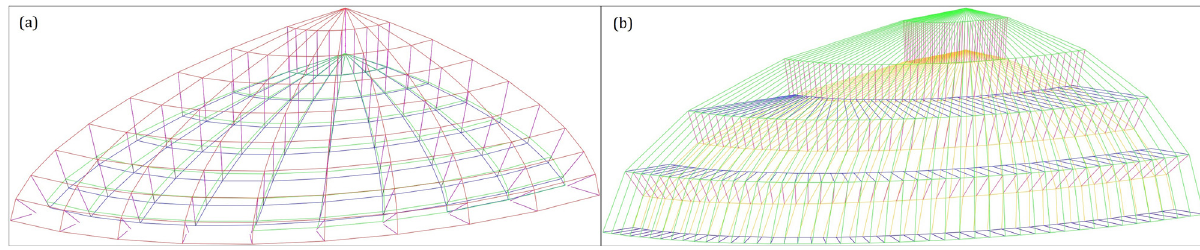
Figure 6: Fragments of the surfaces S u v ,